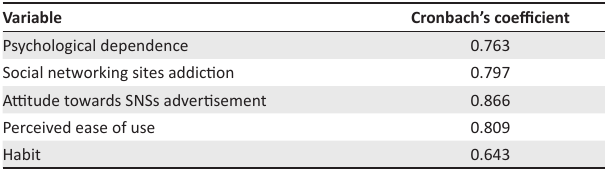
TABLE 1: Reliability of test